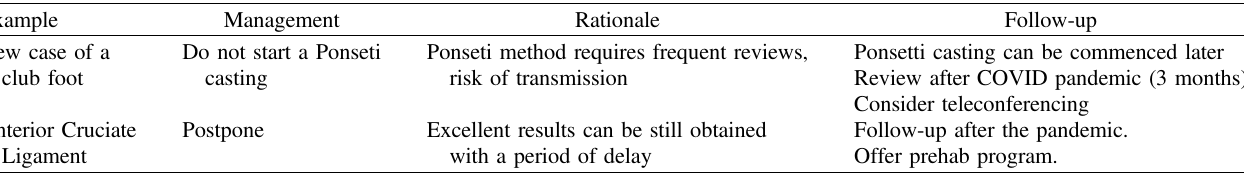
Table 3. Examples for Recommendations for Orthopedic Pediatric Elective Management during COVID-19 pandemic